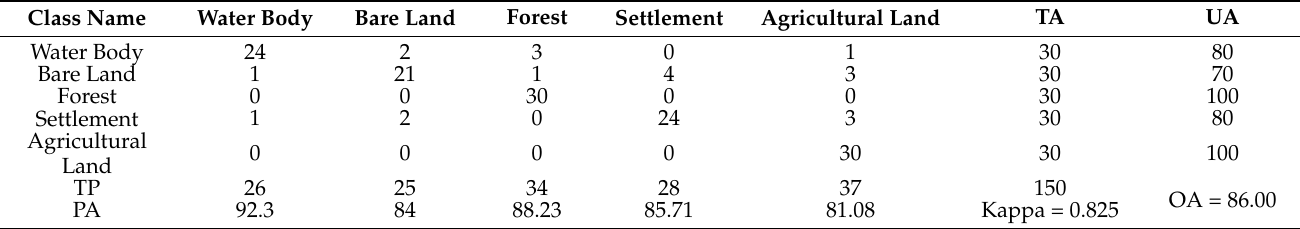
Table 6. Accuracy Assessment of Classified Map of April 2022.